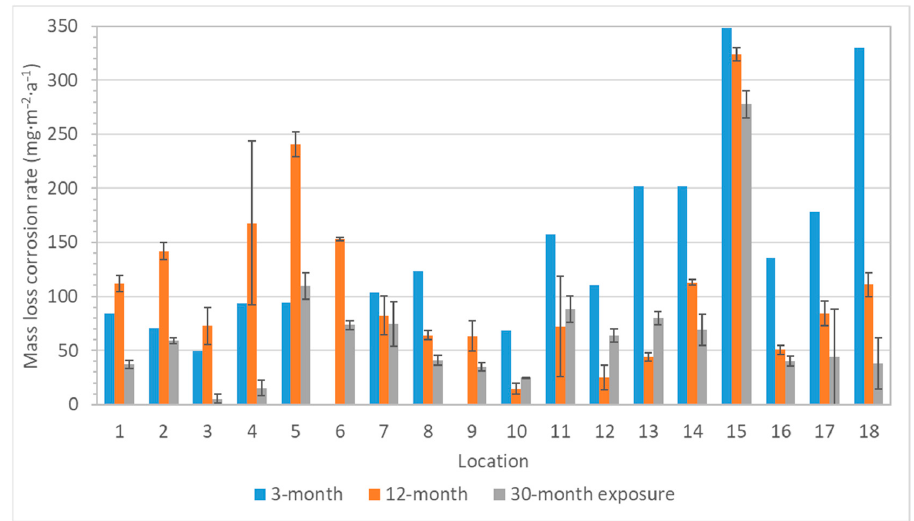
Figure 12. Corrosion rate calculated from mass loss of copper coupons (error bars for 3-month ex- posure are missing due to the small number of exposed samples).